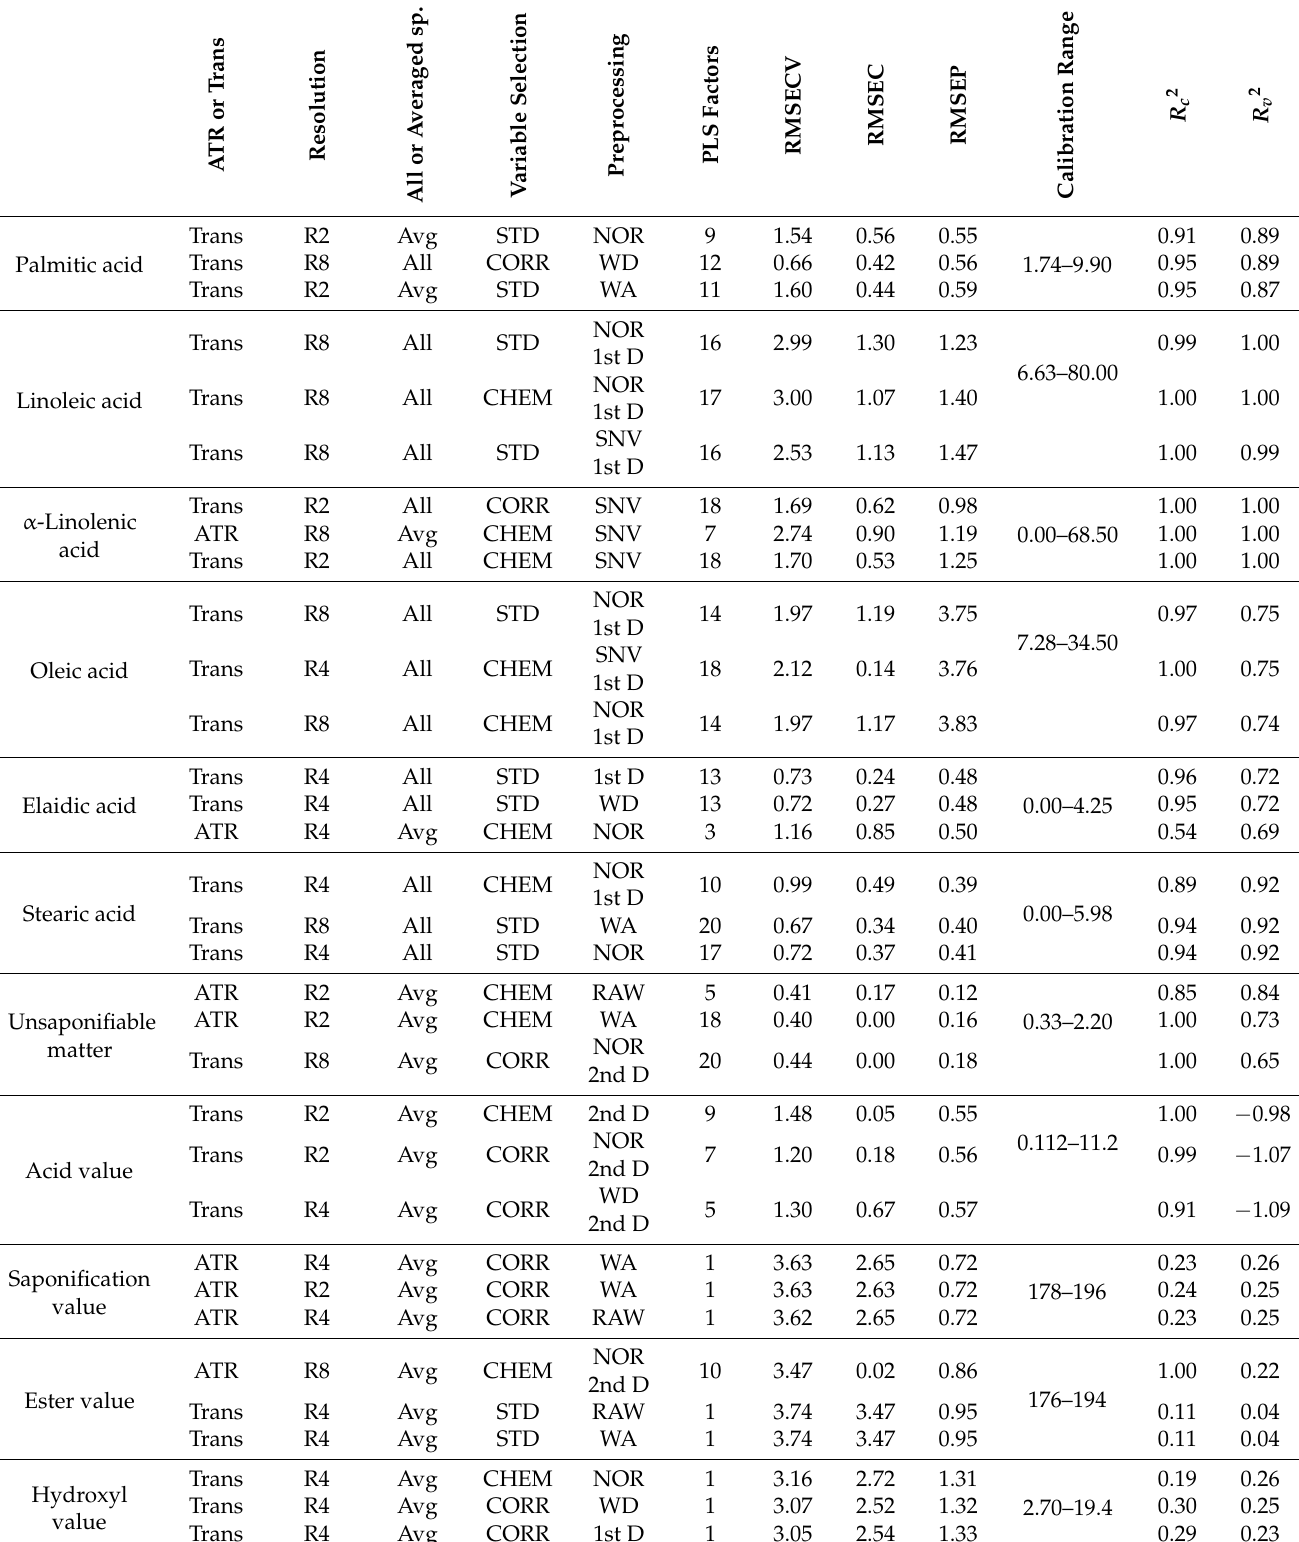
Table 3. Three best models for each dependent variable are presented with the spectral measurement parameters, model building parameters, and evaluation parameters RMSECV, RMSEC, RMSEP, R c 2 , and R v 2